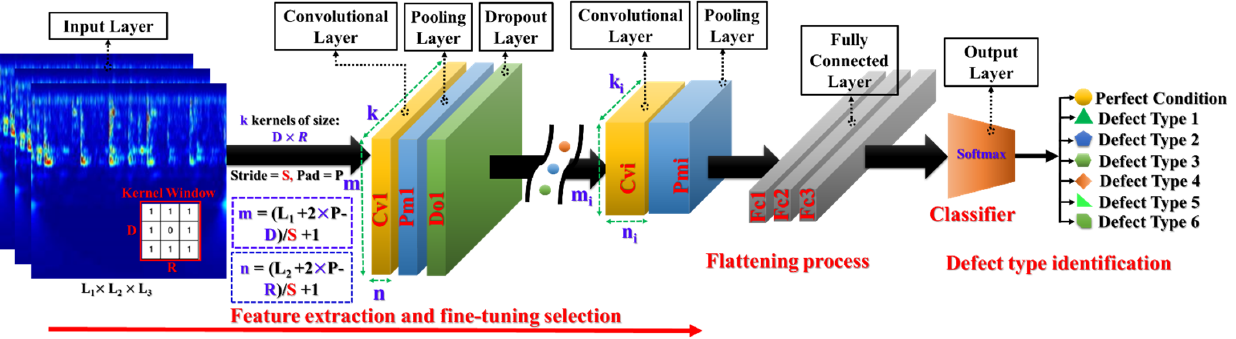
Figure 5. Description of typical DCNA.